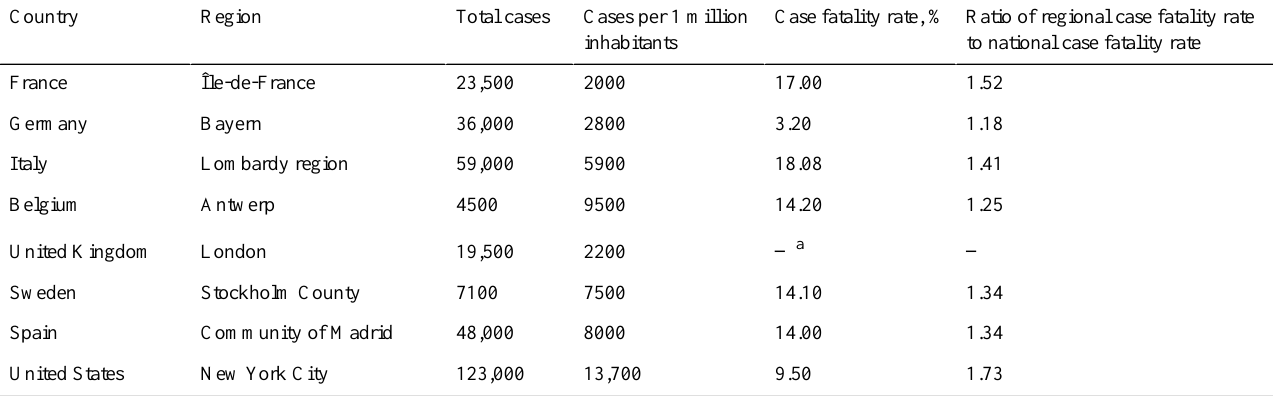
Table 3. COVID-19 statistics for the Lombardy region and for the most affected regions in the other G10